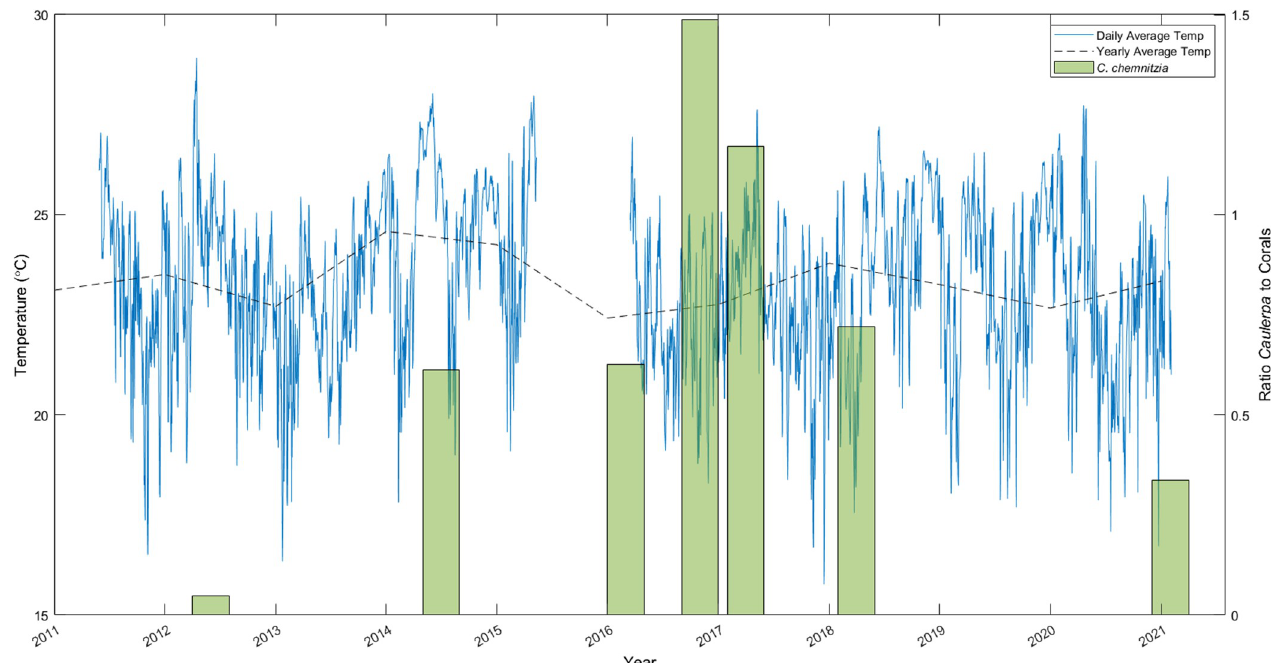
Fig 6. Caulerpa chemnitzia cover at Wellington reef. Graph showing the ratio of C. chemnitzia cover to hermatypic coral cover (green bar) at Wellington reef between 2012 and 2021, with the yearly (black dash) and daily (blue line) averaged 20 m logger temperatures at the Wolf Island anchorage point.